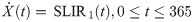
Figure showing the different regimes for varying M.The other parameter values are taken from Table 1. Mathematical description of the three regimes: Regime I: no lockdown, i.e. X˙(t)=SLIR1(t),0≤t≤365, Regime II: lockdown in interval (0, 365), i.e. 0 < τ1 < τ2 < 365, Regime III, lockdown starts immediately, i.e. 0 = τ1 < τ2 < 365.